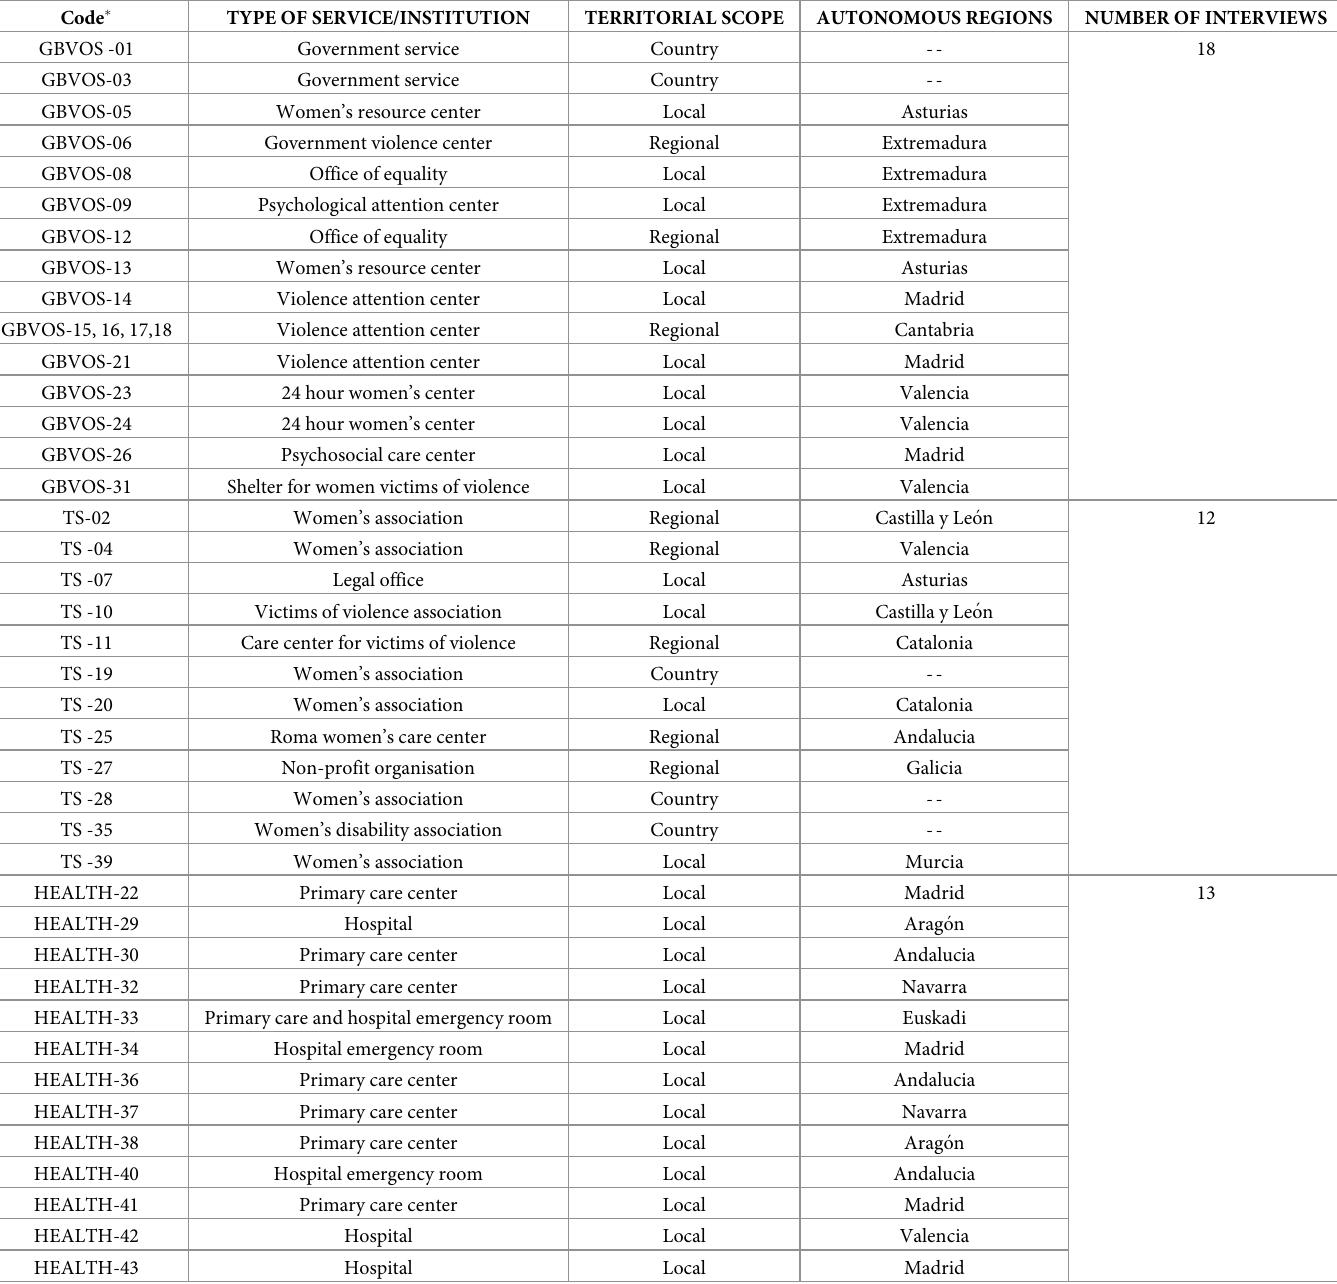
Table 1. Main characteristics of the interviewed social and health services. Code